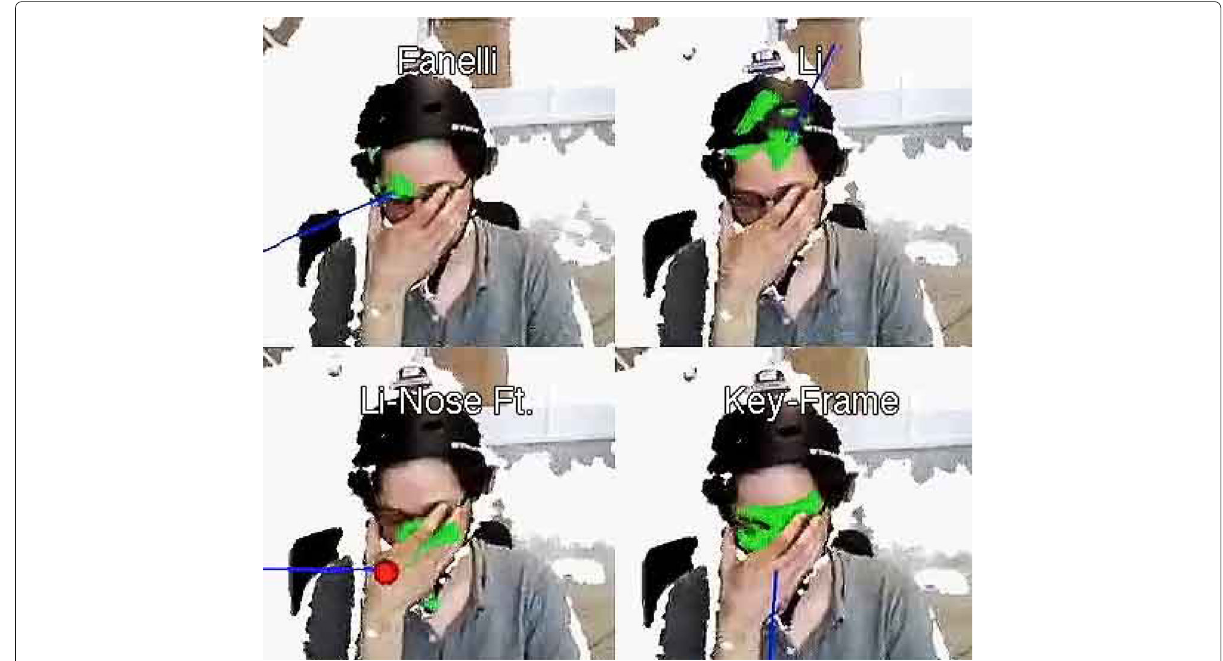
Fig. 13 Qualitative results. Head pose estimated by 4 different proposals using the same